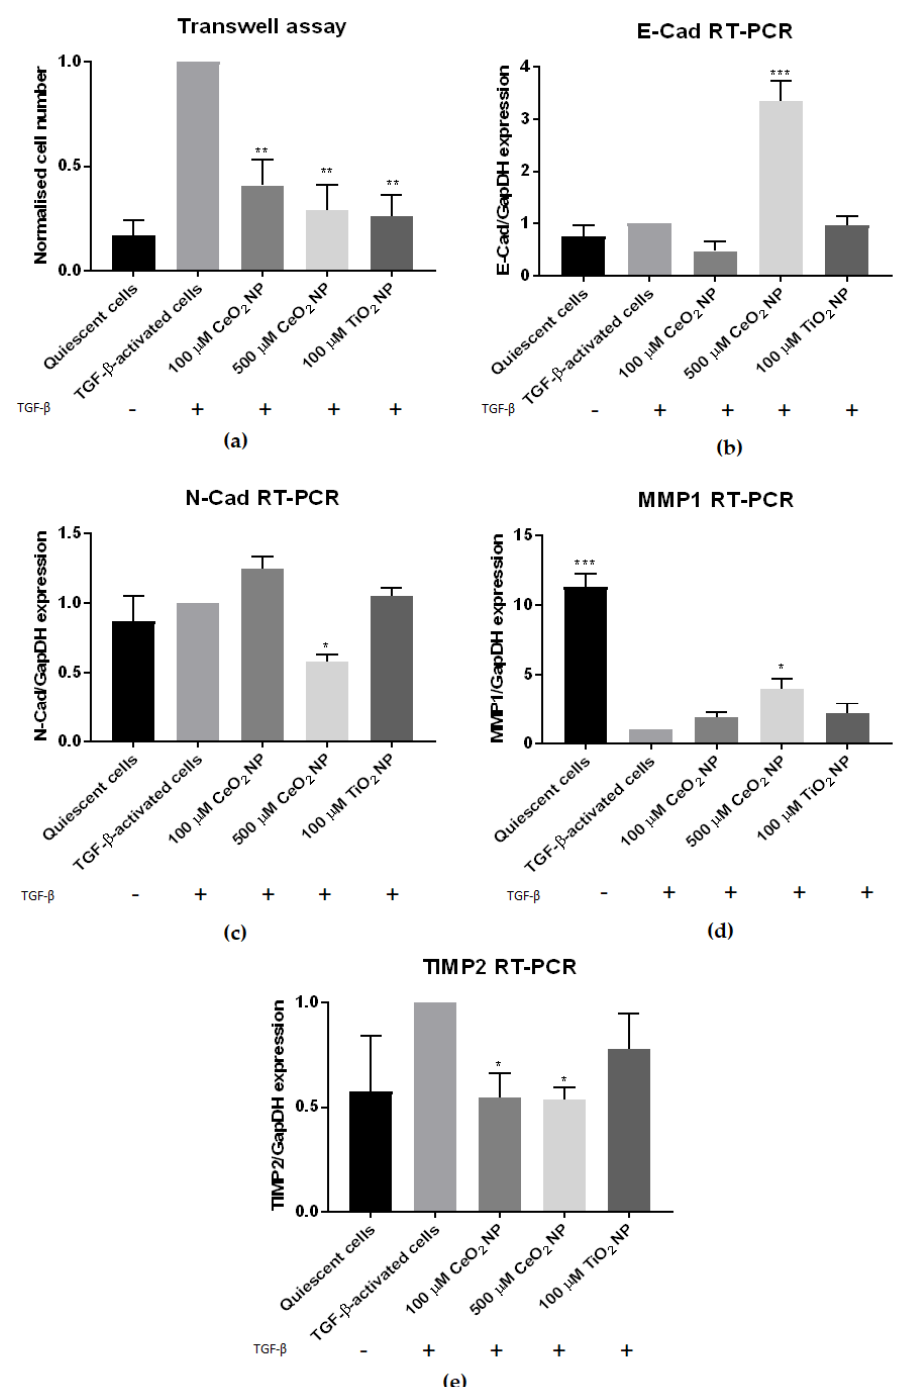
Figure 3. CeO 2 NP-treated cells show reduced hepatic fibrosis hallmarks. ( a ) Transwell assay examining the cell motility of CeO 2 NP-treated cells showed significantly reduced motility in 100 µM, 500 µM and TiO 2 -treated cells. ( n = 3) ( b ) The 500 µM CeO 2 NP-treated cells showed significantly elevated E-cad mRNA expression. ( n = 3) ( c ) The 500 µM CeO 2 NP-treated cells also had significantly reduced N-cad mRNA expression. ( n = 3) ( d ) RT-PCR analysis showed significantly higher MMP1 expression in 500 µM CeO 2 NP-treated cells. ( n = 3) ( e ) TIMP2 mRNA expression was significantly downregulated in 100 µ M CeO 2 NP and 500 µ M CeO 2 NP-treated cells. ( n = 4). Error bars represent SEM; ANOVA was used to calculate significance. * p < 0.05, ** p < 0.01, *** p <